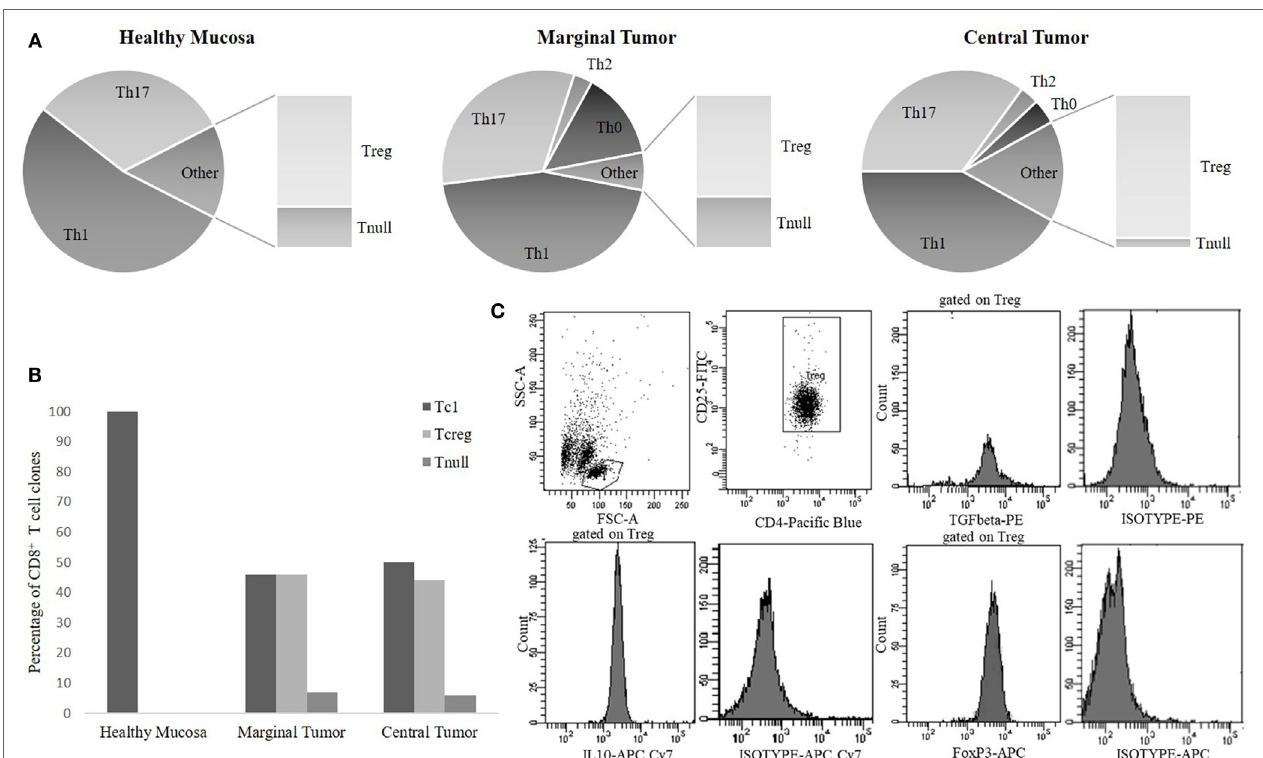
FigUre 2 | The cytokine phenotype distribution of CD4 + T-cell clones (a) and CD8 + T-cell clones (b) . The percentages of CD4 + [T helper1 cells (Th1), Th17, Th0, Treg, Tnull] and of CD8 + (Tc1, Tcreg, Tnull) T cell clones (Tcc) subpopulations were calculated comparing the number of Th/Tc types with the total number of CD4/ CD8 clones obtained from the same tumor tissue sites [healthy mucosa (HM), marginal tumor (MT), and central tumor (CT)]. (c) A representative flow cytometry analysis of a CD4 + Treg clone: anti-CD4, anti-CD25, anti-FoxP3, anti-TGF β , anti-IL-10 mAb, and isotype